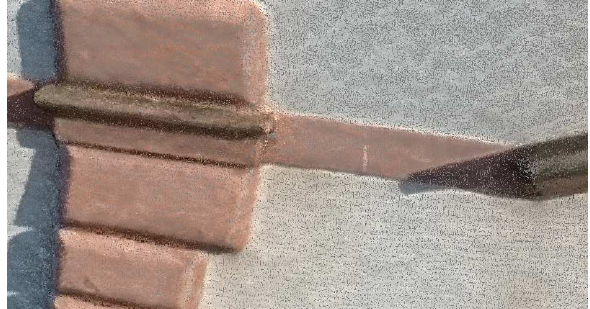
Figure 30: same detail of the cloud obtained from the integrated model (ultra high quality)